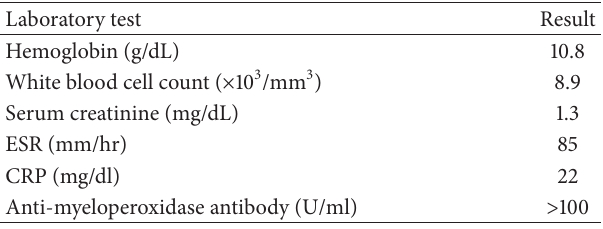
Table 1: Laboratory tests during hospital admission.